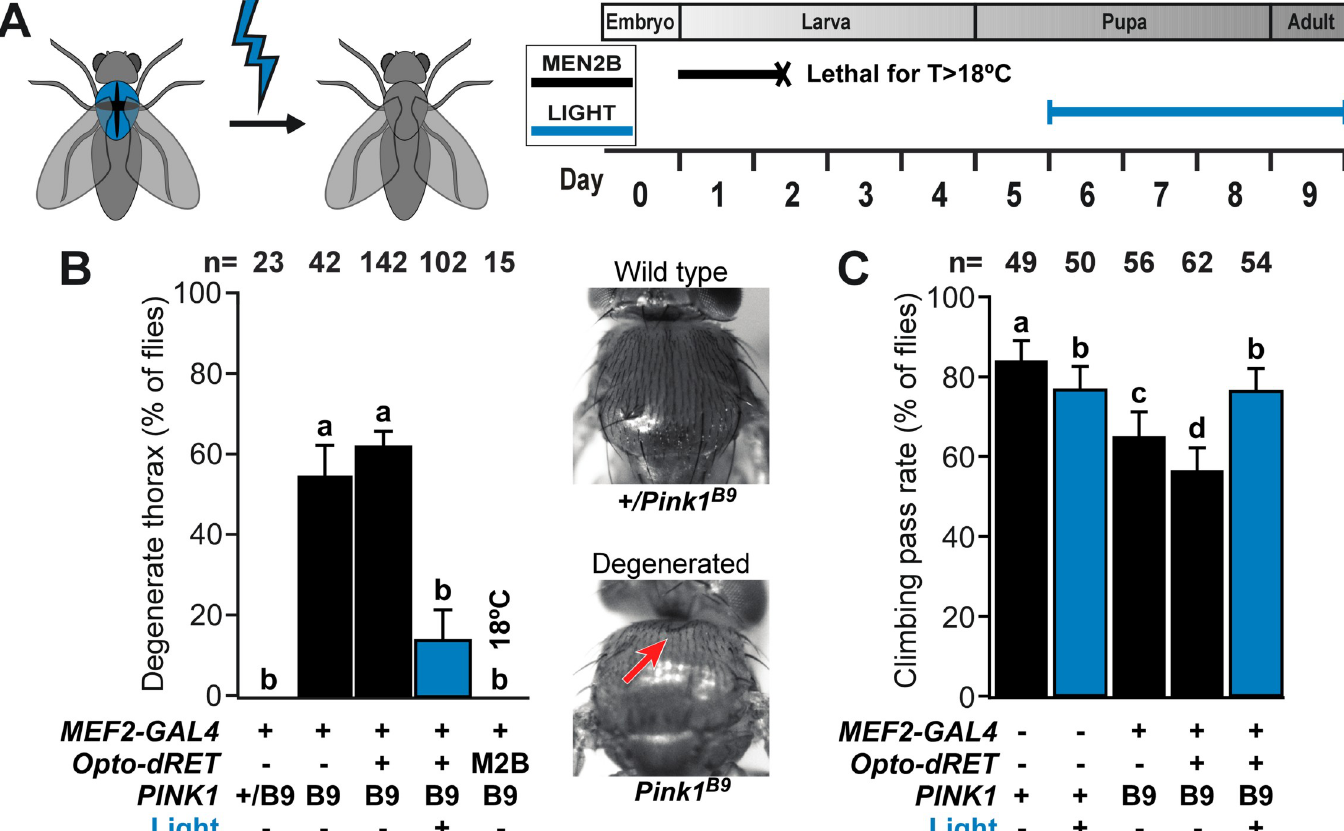
Fig 3. Suppression of thorax defects and locomotion deficits. ( A ) Time window targeted by light in experiments with PINK1 B9 flies. Illumination of pupal and adult stages prevented lethality observed upon Opto-dRET signaling in earlier stages (e.g., Opto-dRET MEN2B flies were grown at 18˚C to prevent lethality during development; see Main Text). ( B ) Percentage of flies with a degenerate thorax phenotype. Representative bright field thorax images shown on the right. Hollow thorax is highlighted by the red arrow. ( C ) Climbing ability of flies. “M2B” denotes Opto-dRET MEN2B . PINK1 “+” denotes the WT gene. For B and C, counts ± SE for the indicated number of flies (n) is given. Percentages sharing the same label are not significantly different (Fisher’s exact test, p > .04). Continuous light intensity was 320 μ W/cm 2 for the duration shown in